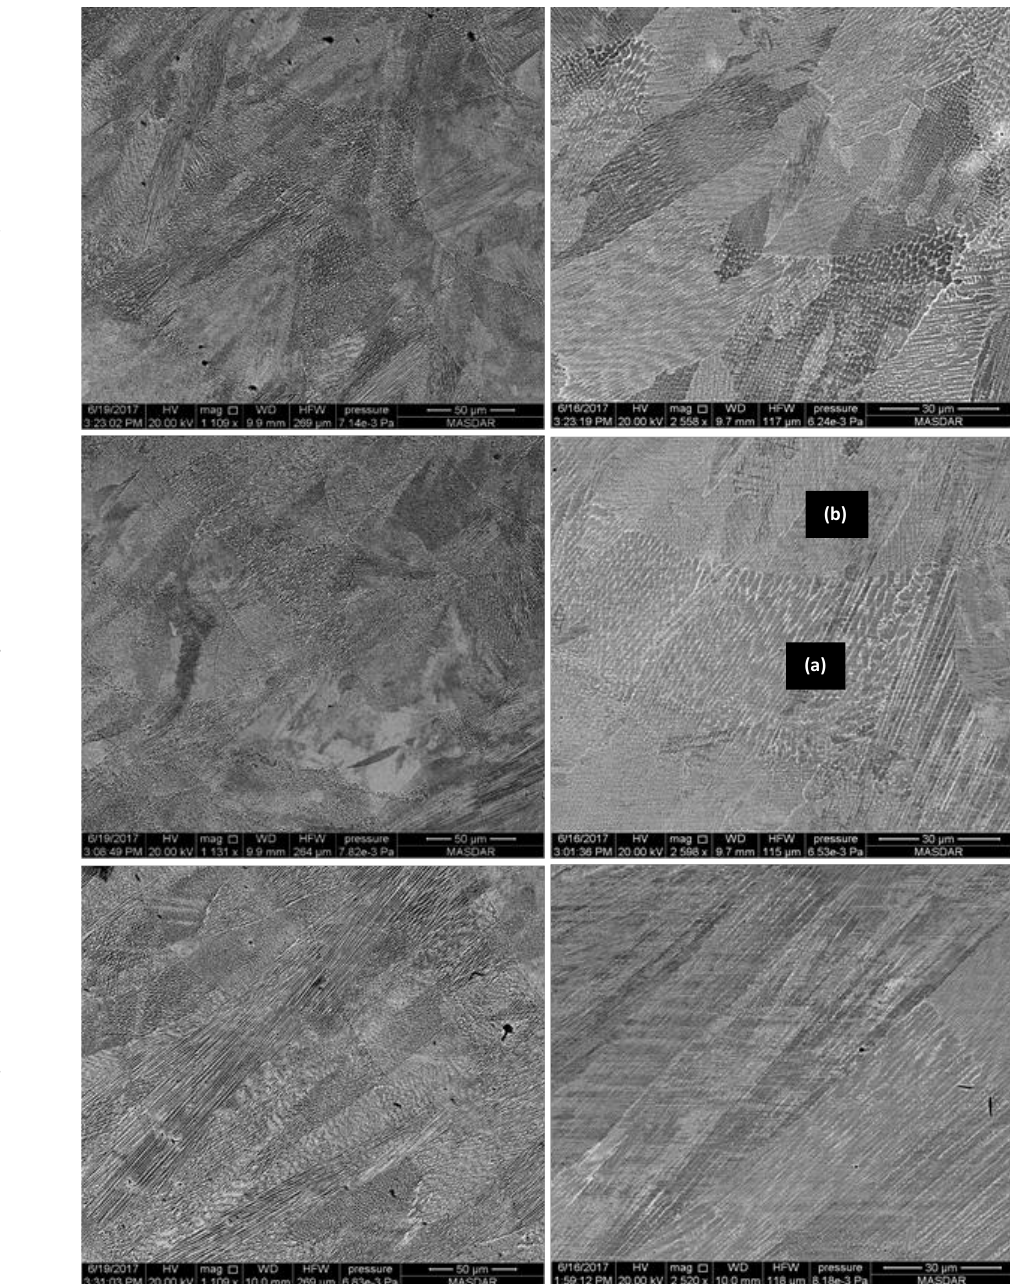
Figure 4. Etched and non-etched SEM images of melt pool boundaries and inter-dendritic structures in the vertical cross-section of the as-printed specimen at the locations indicated in Figure 3.